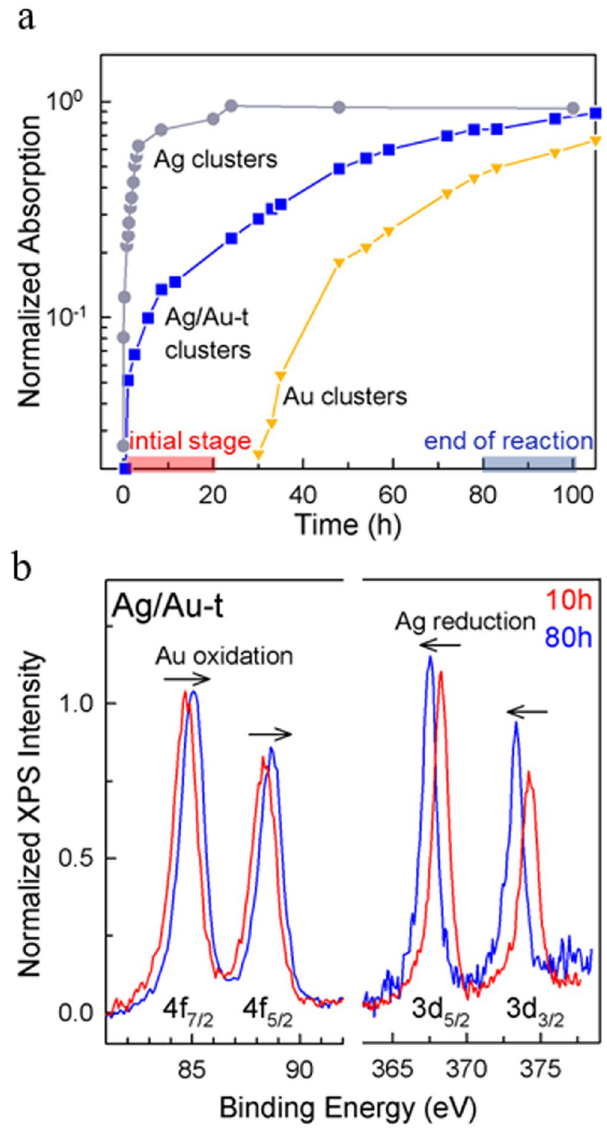
Figure 2. ( a ) Normalized absorption peak intensity measured on aliquots of the reaction medium for Ag (circles), Ag/Au-t (squares) and Au (triangles) clusters as a function of the reaction time. ( b ) XPS spectra of Au and Ag atomic transitions measured on Ag/Au-t clusters after 10 hours and 80 hours of the reaction time. The shift of the binding energies over time indicates the reduction of Ag atoms and the concomitant oxidation of Au